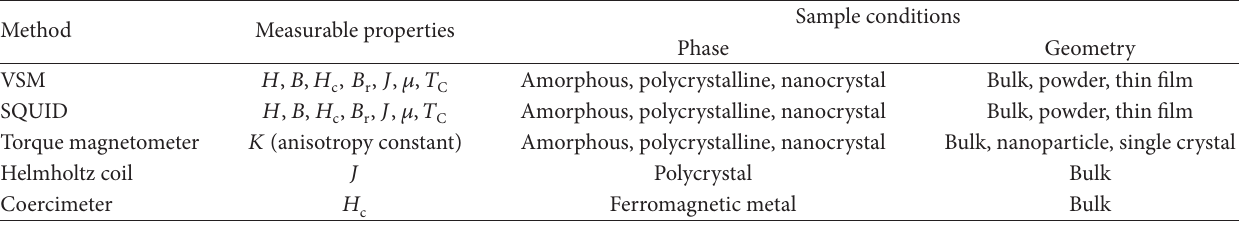
Table 2: The rough comparison of important parameters of different measurement methods like measurable properties and sample